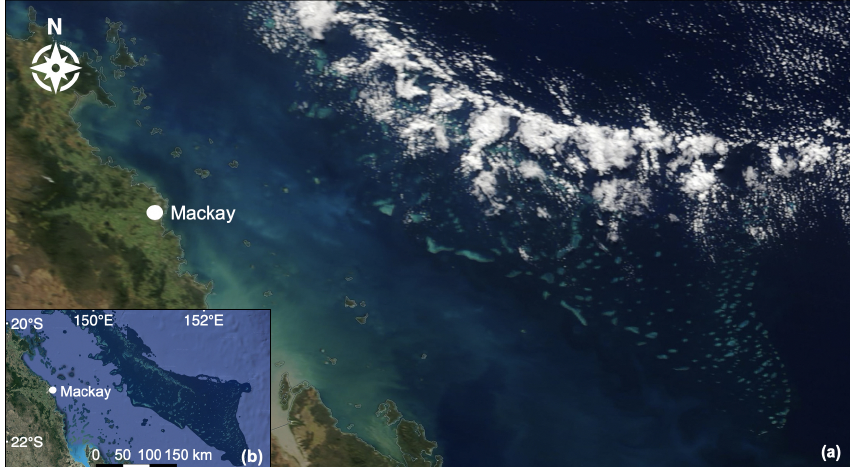
Figure 7. (a) Low-level convective clouds aligned over the Swain Reefs in the Mackay–Capricorn Management Area of the southern GBR. True-colour image captured by MODIS Terra on 31 May 2018 (NASA Earth Observing System Data and Information System). (b) Map of the southern GBR shown to be covered by clouds in the true-colour image (map data © 2019